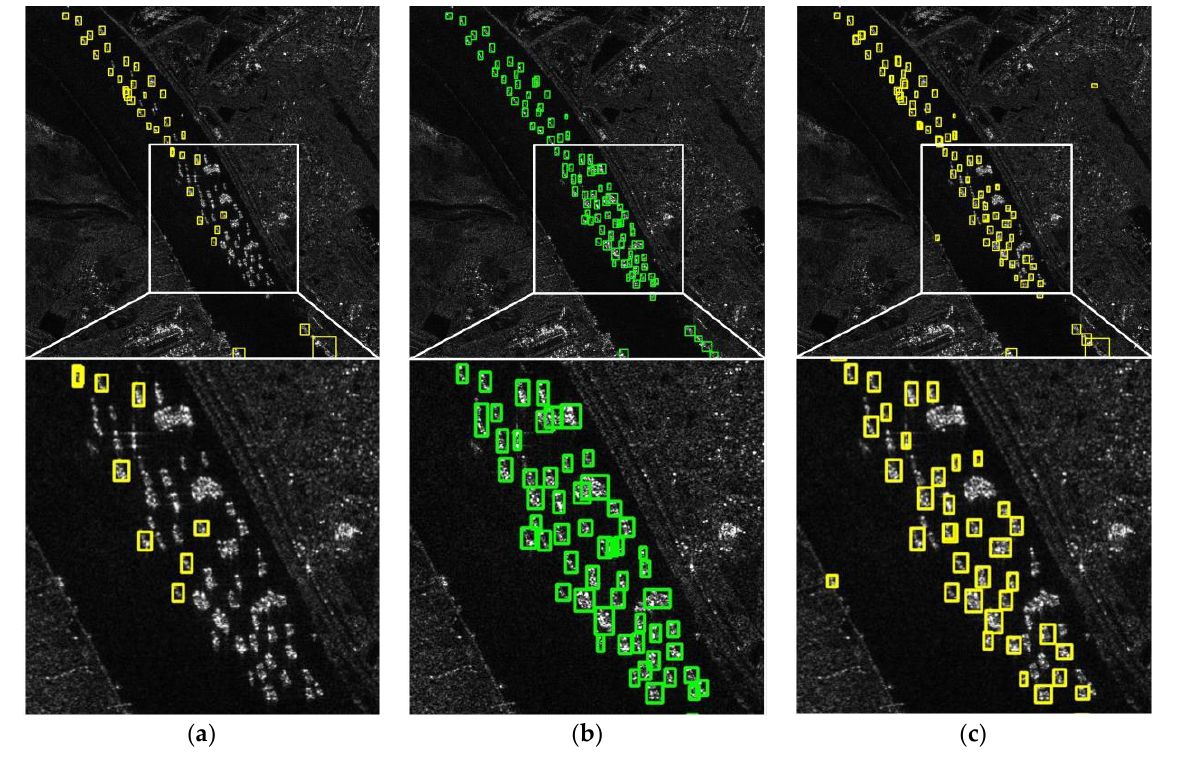
Figure 10. Results in the second river scenario, where the green boxes represent the ship positions marked in the dataset and the yellow boxes represent the detection results inferred by the detection model. ( a ) inference by YOLOX_L, ( b ) the real target frame marked in the dataset, and ( c ) inference by YOLO-SD. Table 6. Specific detection results of Figures 9 and 10.